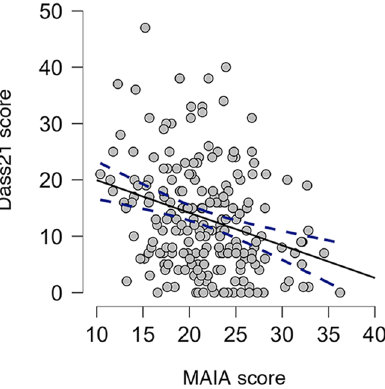
Figure 6. Negative correlation between affect and interoceptive sensibility. Spearman’s rho revealed a significant correlation between the participants’ Dass21 and MAIA scores, i.e., lower levels of affect were negatively correlated with higher levels of interoceptive sensibility. Dashed lines denote confidence interval; n =